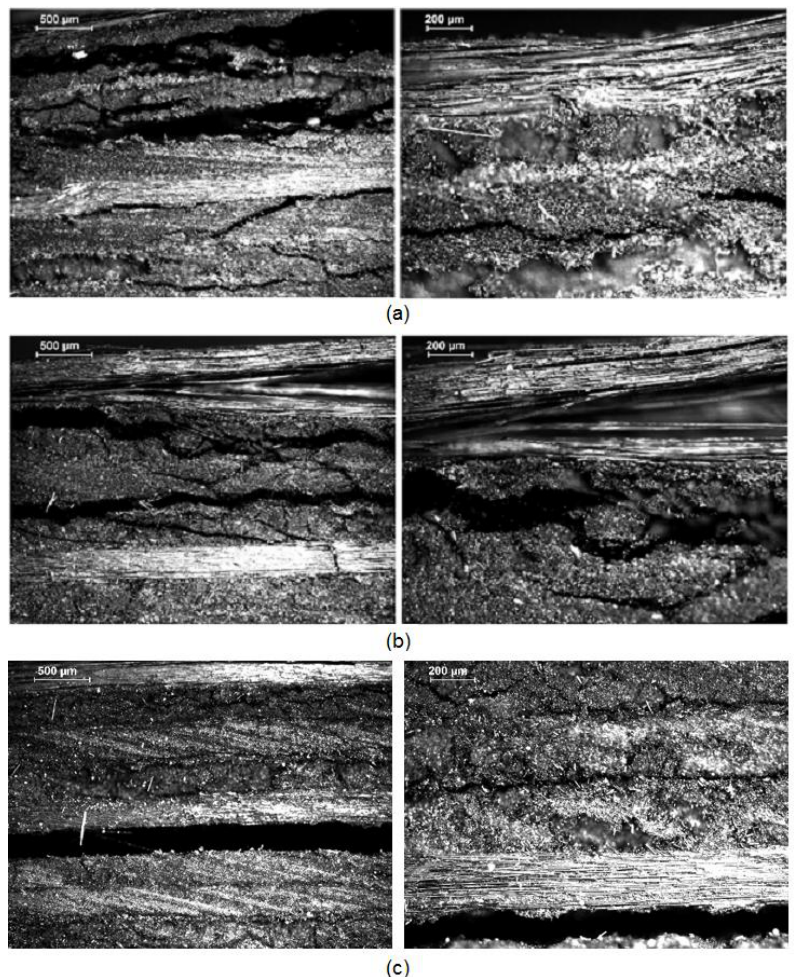
Figure 11. Cross sectional optical micrographs of the failure areas of flexural quasi-isotropic [0/90/±45] 2s samples. ( a ) Non-Aged; ( b ) aged at 190 °C for 10 days, ( c ) aged at 250 °C for 10 days.